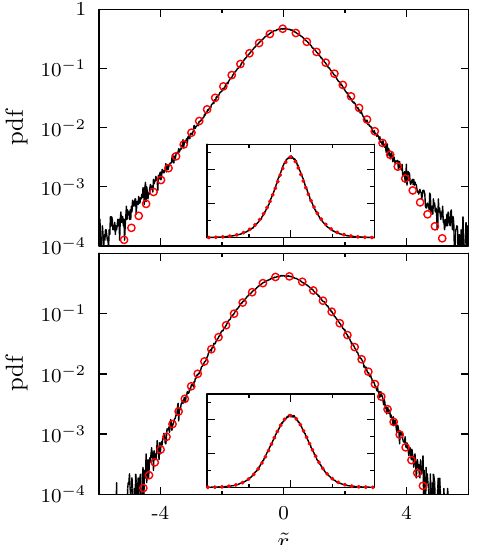
Figure 4. Aggregated distribution of the rotated and scaled returns ˜ r for ∆ t = 1 ( top ) and ∆ t = 20 ( bottom ) trading days. The circles correspond to the aggregation of the distribution (13). Reproduced with permission from (Schmitt et al. 2013), EPLA.